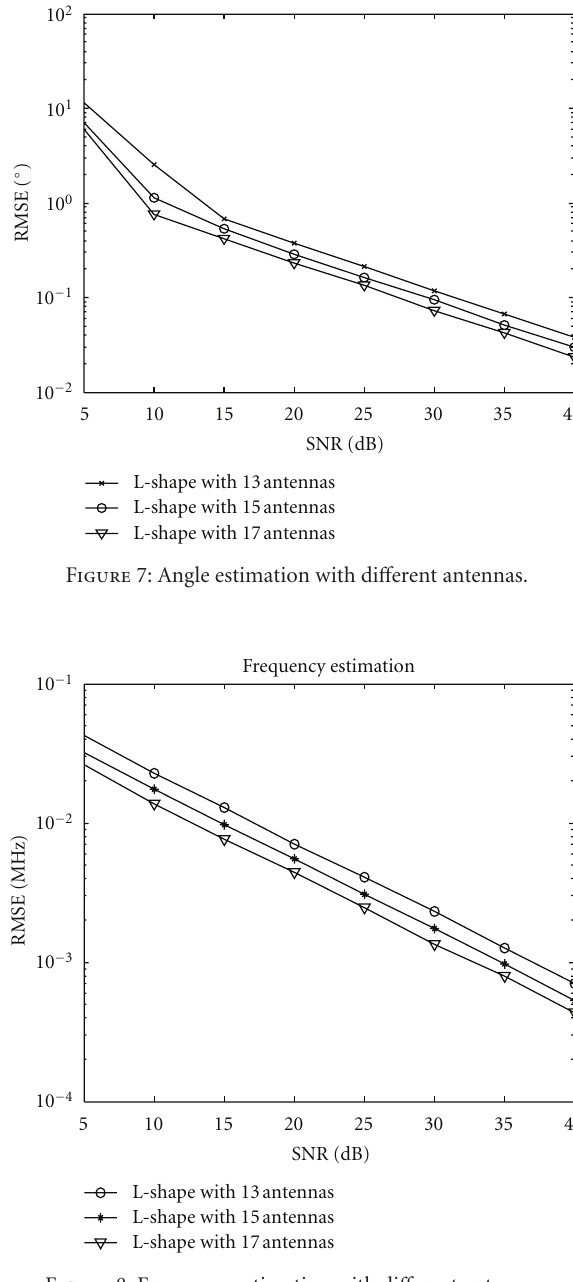
Figure 8: Frequency estimation with di ff erent